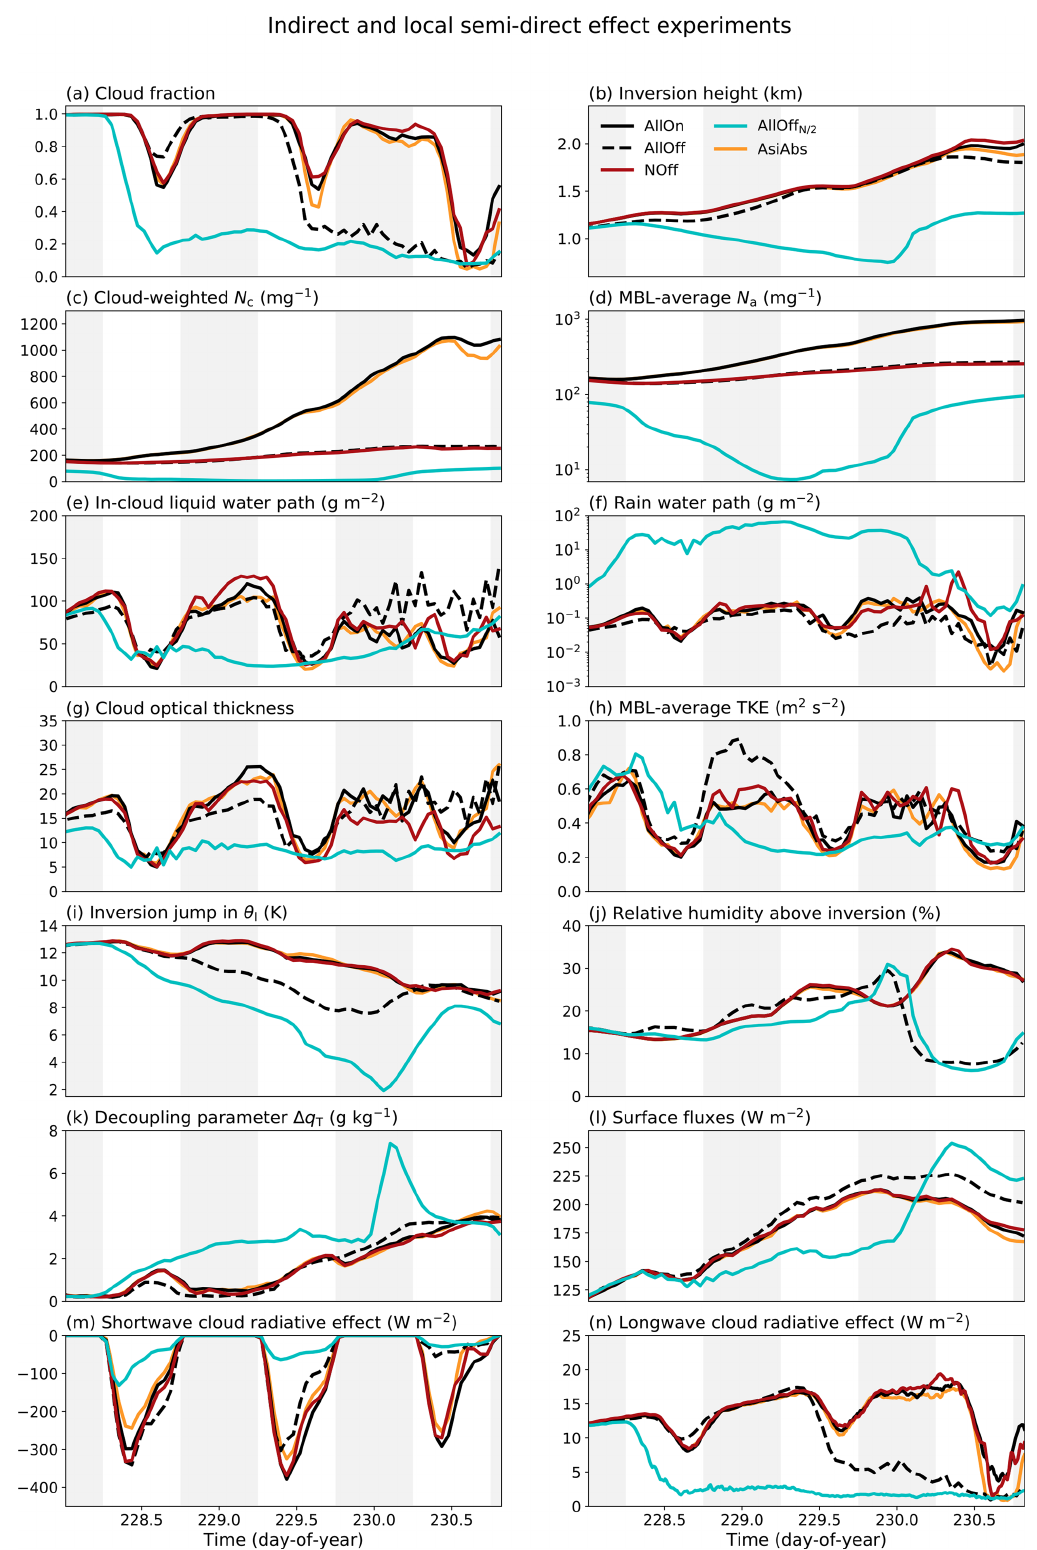
Figure 15. Evolution of various cloud and MBL properties over the course of the Lagrangian simulations for AllOn and AllOff along with the microphysics-focused and local semi-direct sensitivity tests. Subplots are as in Fig. 7 but for the LES base cases and NOff (red), AllOff N / 2 (cyan), and AsiAbs